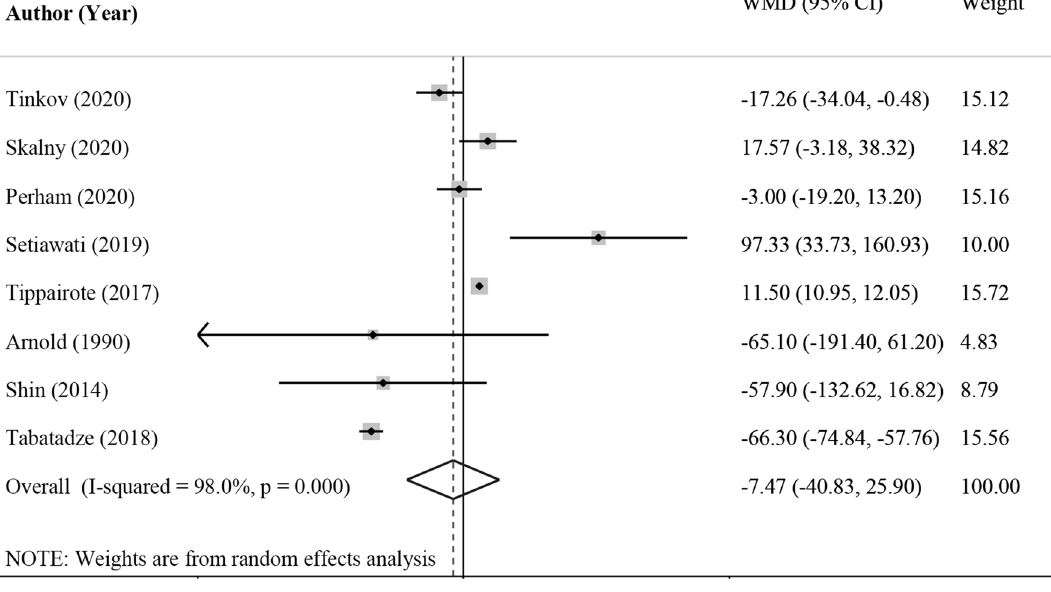
Figure 3. Forest plot for the association between hair zinc level and ADHD expressed as mean difference between case and control groups. The area of each square is proportional to the inverse of the variance of the WMD. Horizontal lines represent 95%Cis. Diamonds represent pooled estimates from random-effects analysis. WMD, weighted mean difference. All statistical analyses were performed using Stata version 14